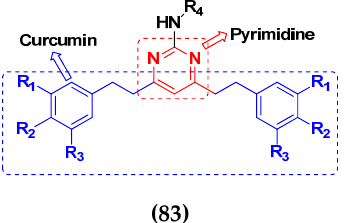
Figure 80. Structure of curcumin-pyrimidine derivatives ( 83 ). Table 69. In vitro cytotoxic activities of curcumin-pyrimidine hybrid compounds 83 ( a – c ). Compound.